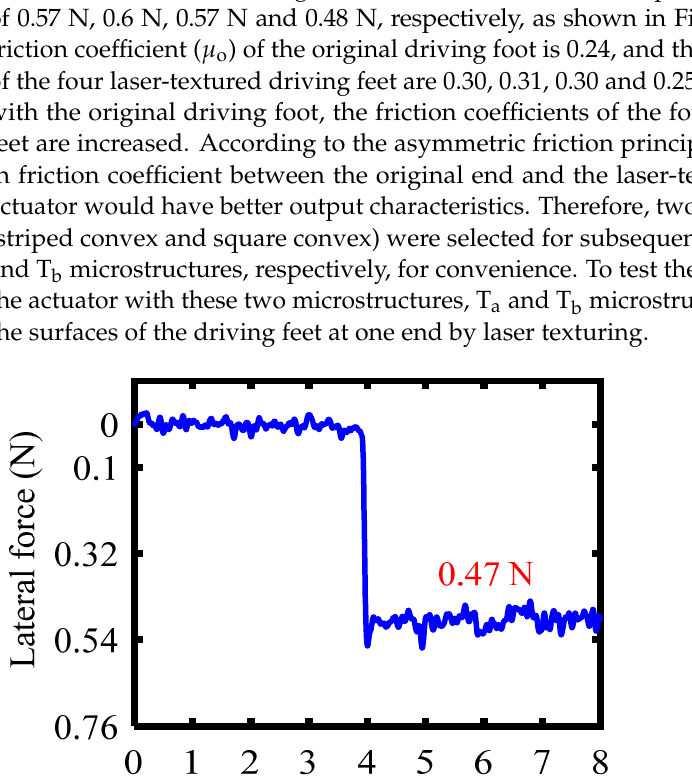
Figure 7. Lateral force–time curves of the four laser-textured driving feet: ( a ) striped convex, ( b ) square convex, ( c ) circular convex and ( d ) circular concave. 4. Experiments and Output Characteristics of the Actuator To verify that the actuator could also achieve the stable motion by tuning the friction coefficients between the SCM and two parallel guide rails, a prototype was fabricated, and its output characteristics were tested using the experimental system, as shown in Figure 8. The signal generator (DG4062, RIGOL Technologies, Suzhou, China) produces a saw- tooth-type driving voltage signal. Then, the signal is enlarged 15 times by the signal am- plifier (E01.A3, Harbin Core Tomorrow Science & Technology Co., Ltd., Harbin, China) and applied to the PES (5 mm × 5 mm × 20 mm, AE0505D16DF, TOKIN, Japan; nominal displacement output: 17.4 ± 2.0 μ m at 150 V) to drive the prototype. The motion displace- ment of the prototype was tested by a laser displacement sensor (ILD2300-2, Micro-Epsi- lon, Ortenburg, Germany), and the collected data were further processed by the IPC. The corresponding height between the prototype and laser displacement sensor was adjusted by the lifting platforms.